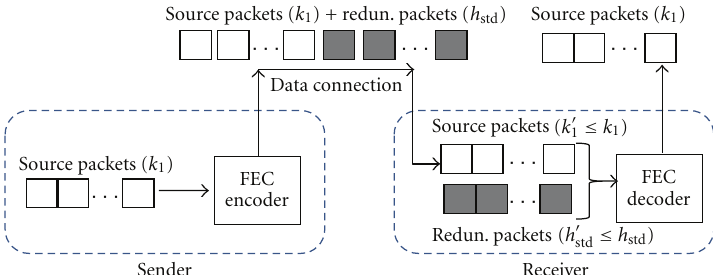
Figure 1: Overview of standard packet-level FEC scheme. This figure shows the FEC coding operations at both the sender and receiver. The maximum amount of loss packets that can be recovered is h std .